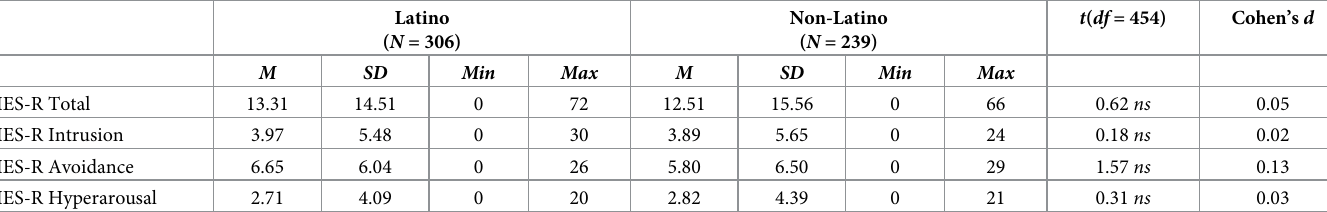
Table 2. Descriptive statistics, t-statistics, and Cohen’s D comparing Latino and Non-Latino participants on IES-R